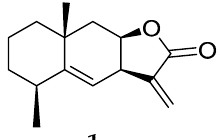
Figure 2. Structure of alantolactone ( 1 ).